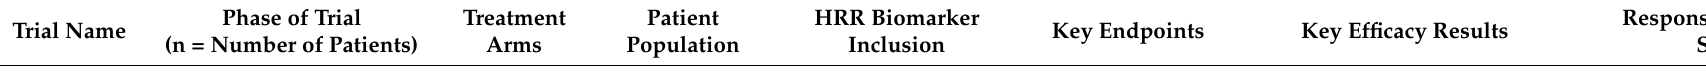
Table 1. Single agent PARP inhibitor trials in metastatic castrate resistant prostate